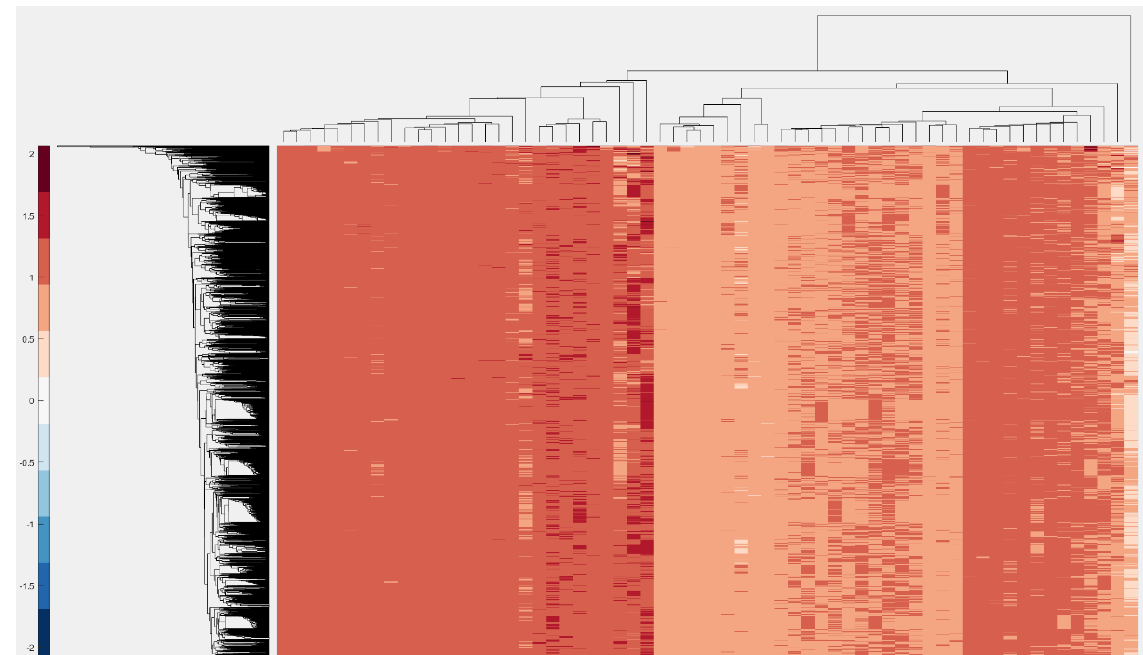
Figure 6. Here, we selected the D ‐ ratio for computing the motifs and substrings with length of 2 and the Cluster Map method to cluster the data.